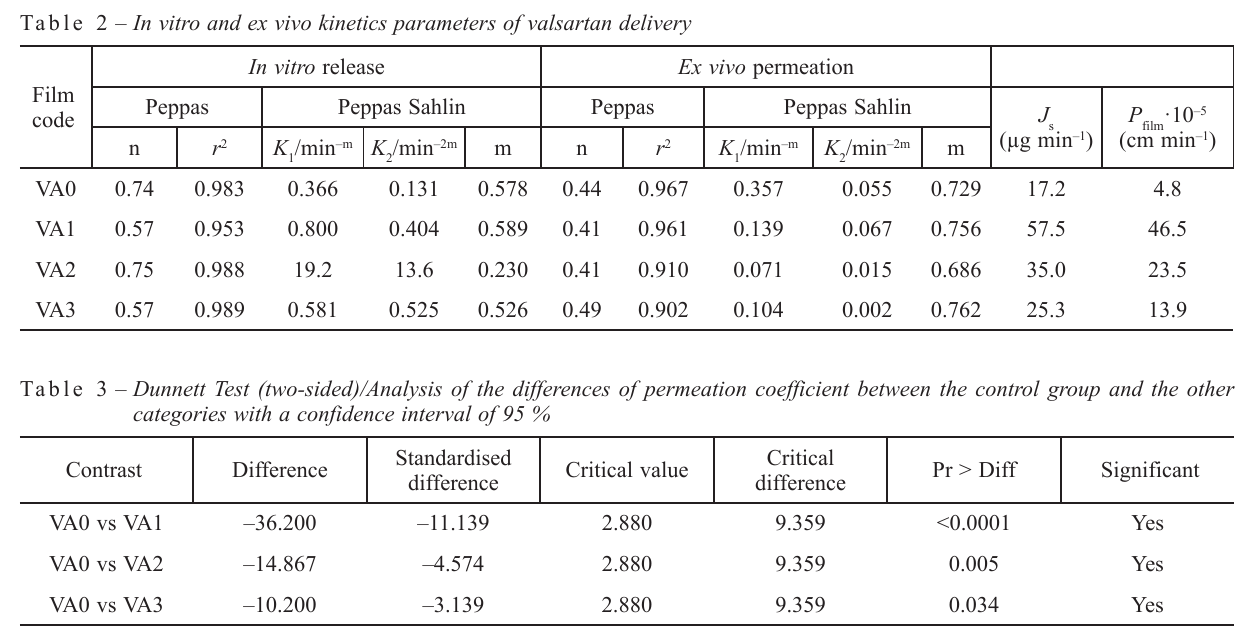
Table 2 – In vitro and ex vivo kinetics parameters of valsartan delivery In vitro release Film Peppas code